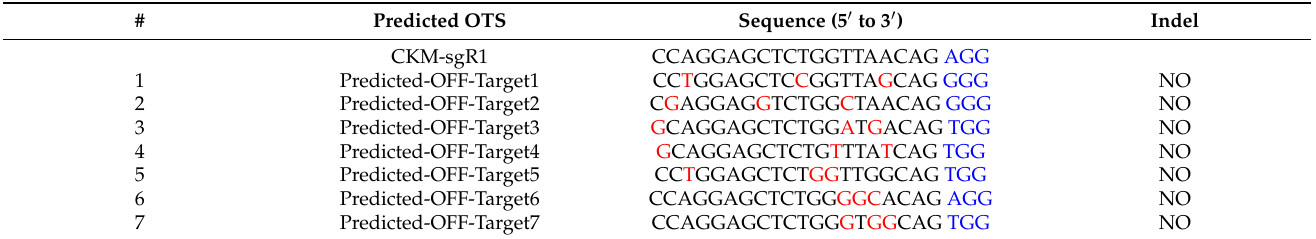
Table 1. Analysis of potential off-target sites. Seven potential off-target sites were selected, and the off-target results were identified by PCR- sequencing. Blue letters indicate the PAM (protospacer adjacent motif) sequence. Red letters mark differences in sgRNA compared with the target sequence. Indel column shows the detected off-target results.